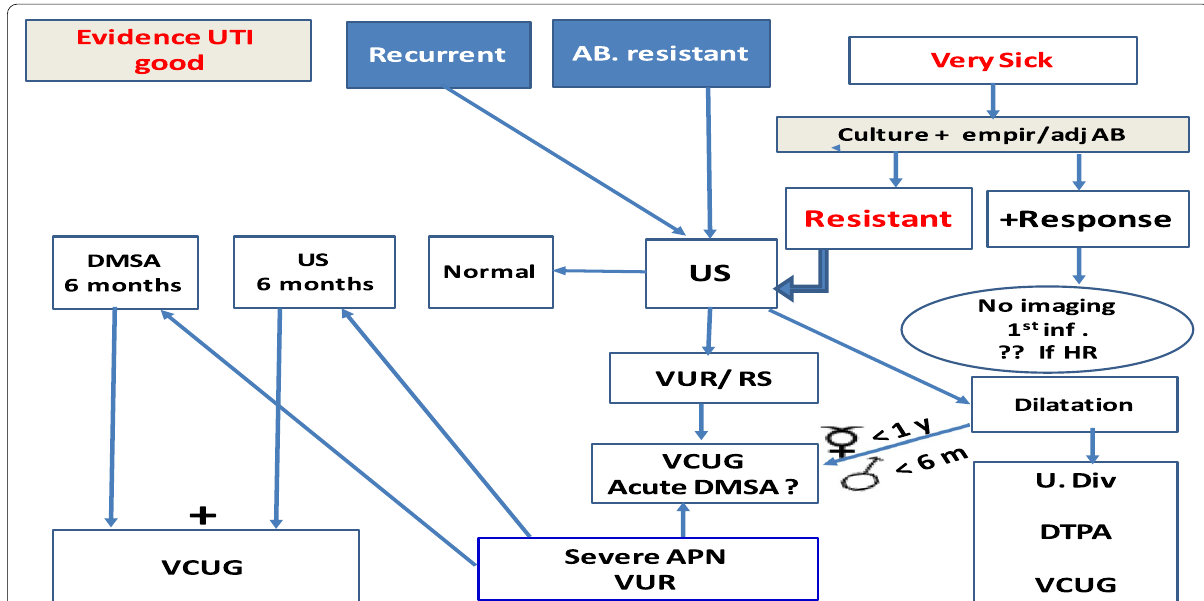
Fig. 6 National imaging recommendation plan. AB antibiotic, empir empirical, Adj AB adjusted antibiotic, US ultrasound, VUR vesico-ureteric reflux, RS renal scarring, VCUG voiding cystourethrography, APN acute pyelonephritis, DMSA Technetium-99m (dimercaptosuccinic acid), DMSA 6m. 6 months post-infection, DTPA diethylenetriamine pentaacetic renogram, U. Div ureteric